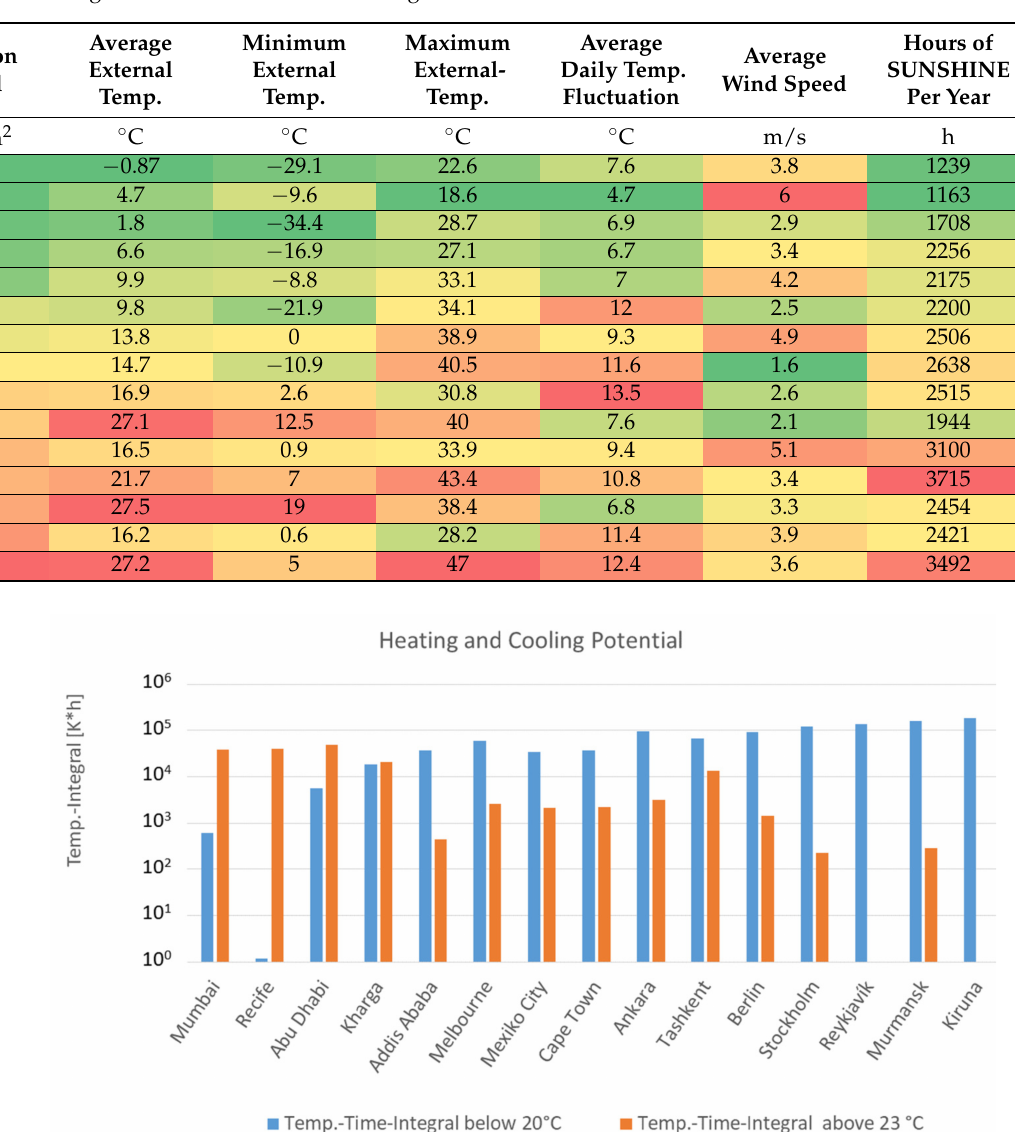
Table 2. Climatic characteristics for the sites under consideration. Background colors vary from red to yellow to green for each column, with red indicating the maximum value and dark green the minimum value.